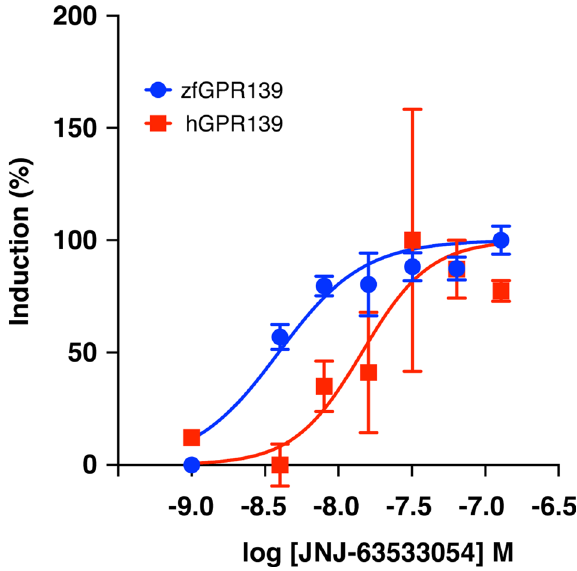
Figure 2. Dose–response curves for luciferase induction by GPR139 agonist JNJ-63533054 upon zebrafish GPR139 in HEK293-T cells. Graphs showing concentration-dependent induction firefly luciferase activity divided by Renilla luciferase activity (%) in the HEK 293 T cells expressing zebrafish GPR139 (blue) and human GPR139 (red) by JNJ63533054 (4 ~ 128 nM). The EC50 values (3.91 nM and 14.45 nM for zebrafish GPR139 and human GPR139, respectively) were calculated by nonlinear regression analysis of the dose–response curves generated using the Prism 9 program. All data points are representative of three independent experiments performed in